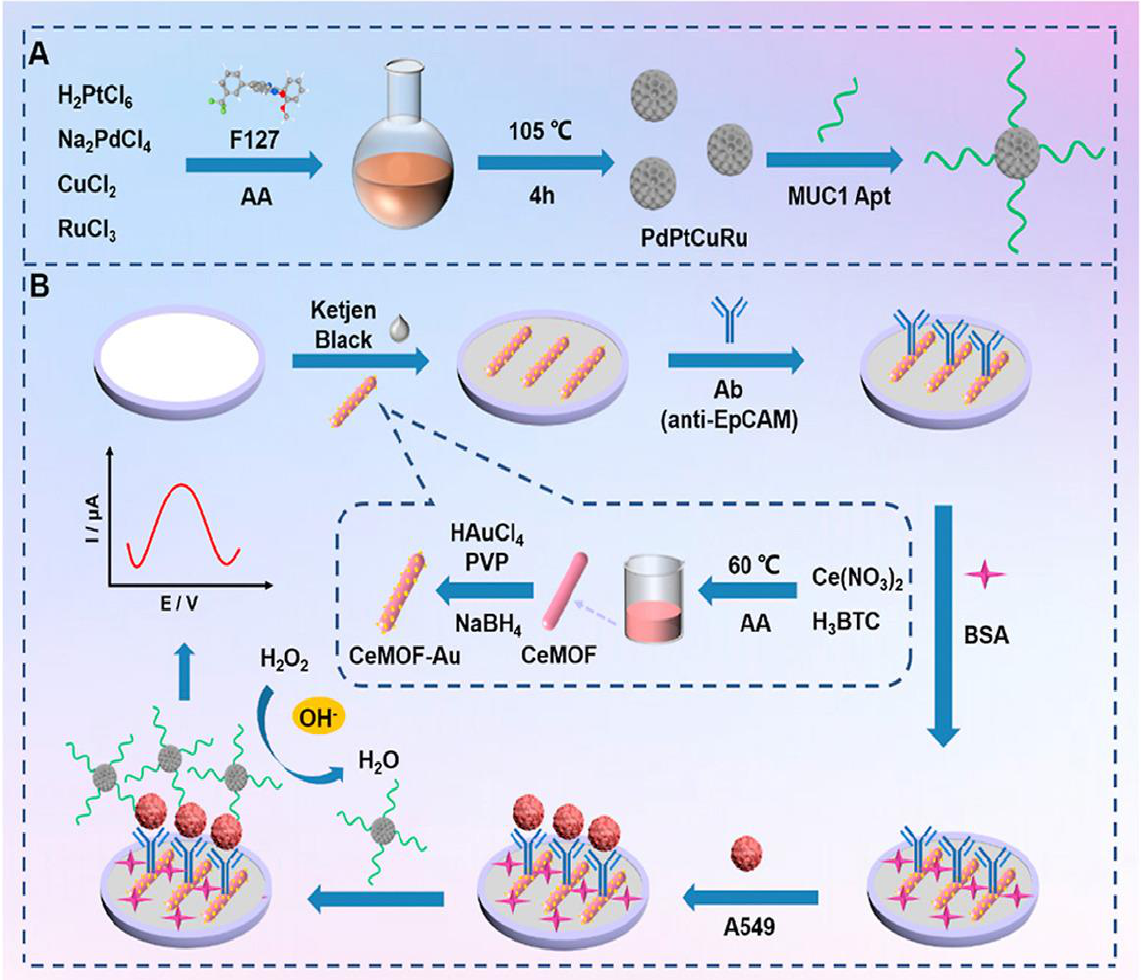
Figure 5. ( A ) The synthesis procedure of PdPtCuRu MNSs. ( B ) Construction of the sandwich-type electrochemical biosensor [136].